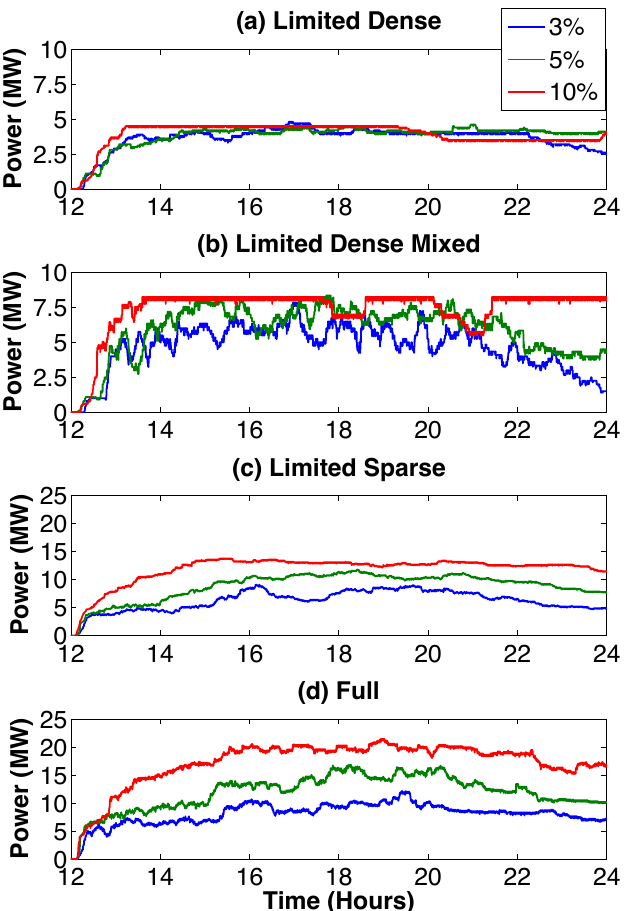
Figure 11. Charging system load curves for all 12 simulation